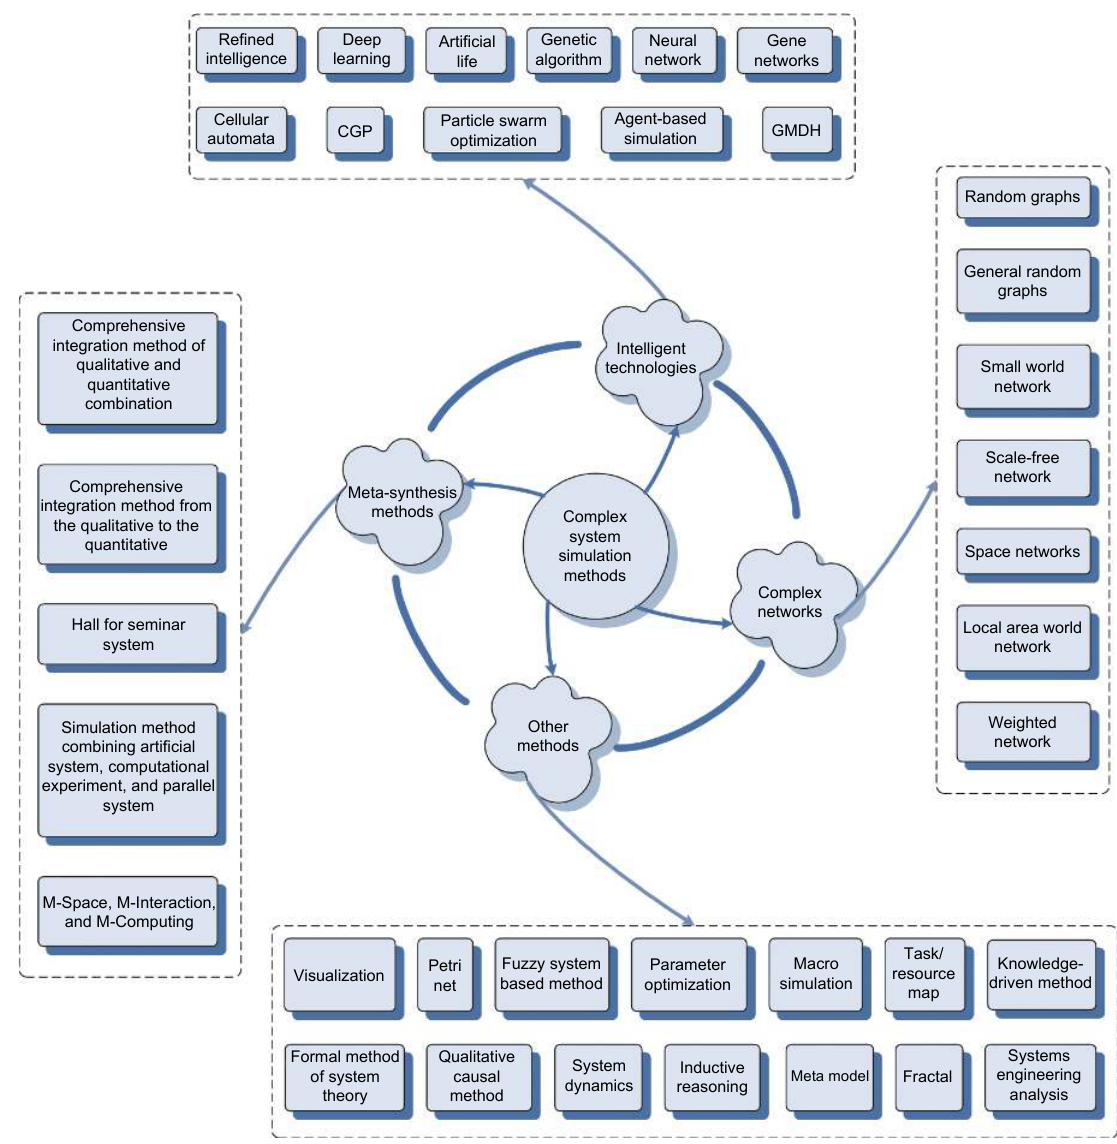
Fig. 2 Research layout of complex system simulation